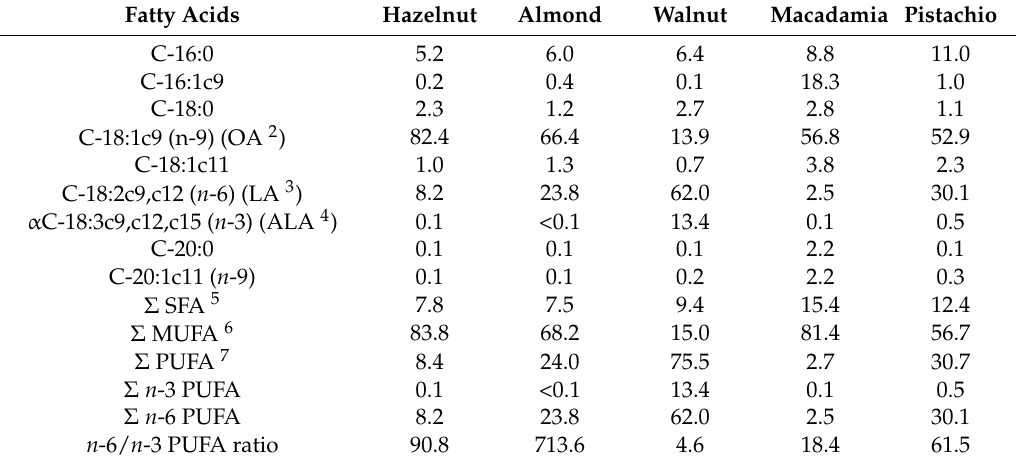
Table 1. Fatty acid composition (% of total FAME 1 ) of the oily nut extracts after in vitro digestion. Fatty Acids